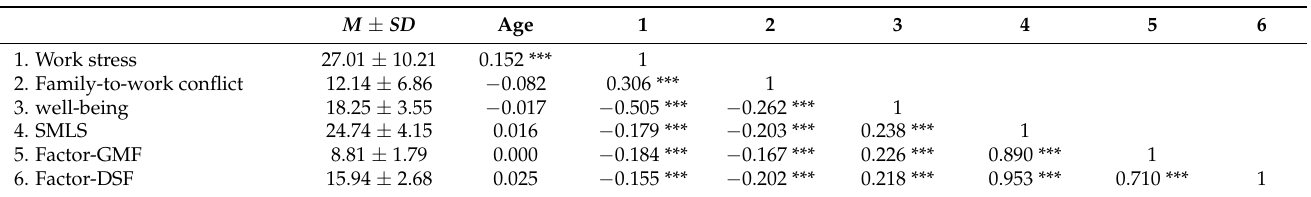
Table 1. Descriptive statistics and correlation of variables ( n = 562), Pearson correlation coefficients of all variables.